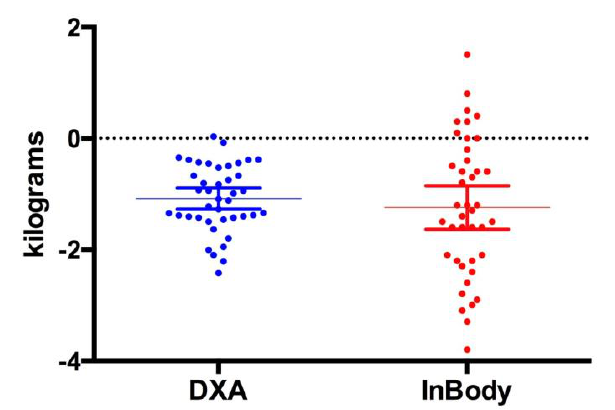
Figure 2. Change in Fat Mass. This figure shows individual data points comparing the DXA vs. InBody BIA. The data is presented as the mean (middle horizontal line) with a 95% confidence interval (CI). DXA: Lower 95% CI of mean −1.272, Upper 95% CI of mean −0.8924, InBody: Lower CI of mean −1.637, Upper CI of mean −0.8512.